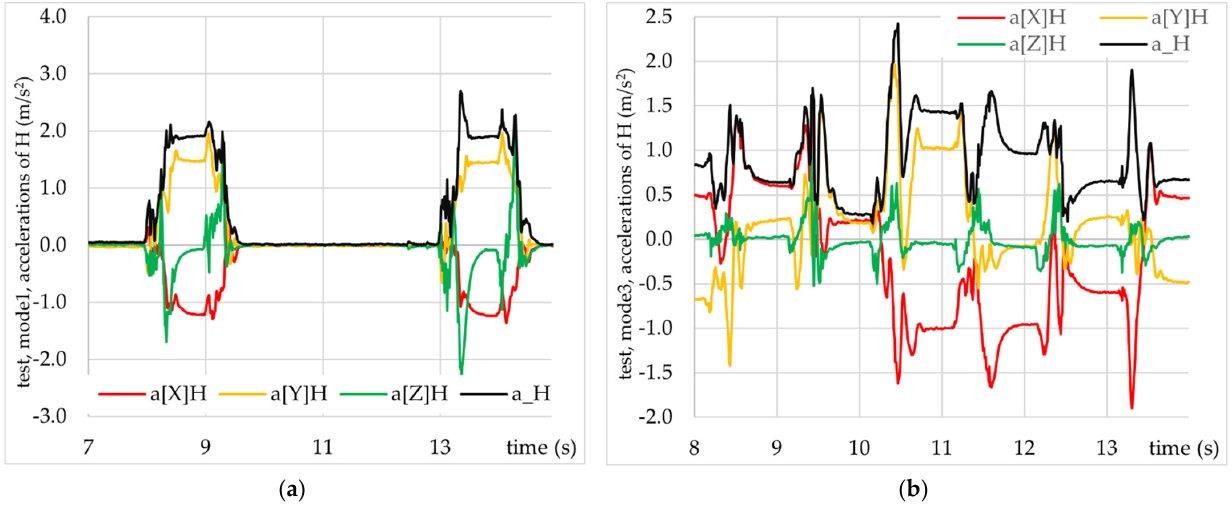
Table 6. Comparison of the results from the dynamic simulation and real tests.